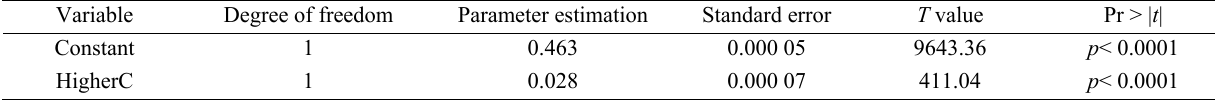
Table 6 Test of the impact of investors’ social network on trading